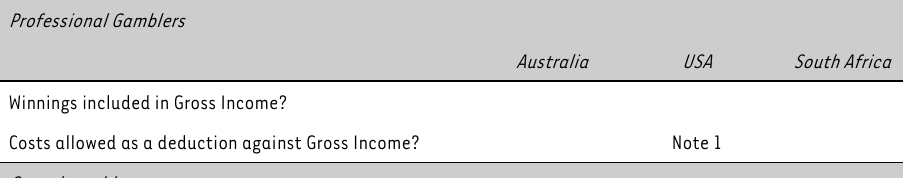
TABLE 1: Key differences between the taxation of gambling winnings in South Africa, Australia and the